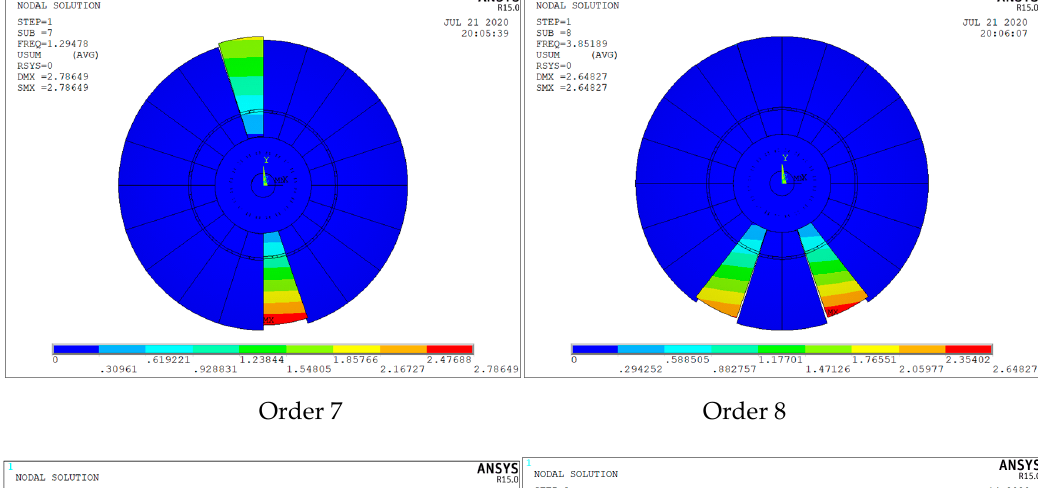
Figure 8. First order mode shapes of Model 1 and 2 in 3D visualization.